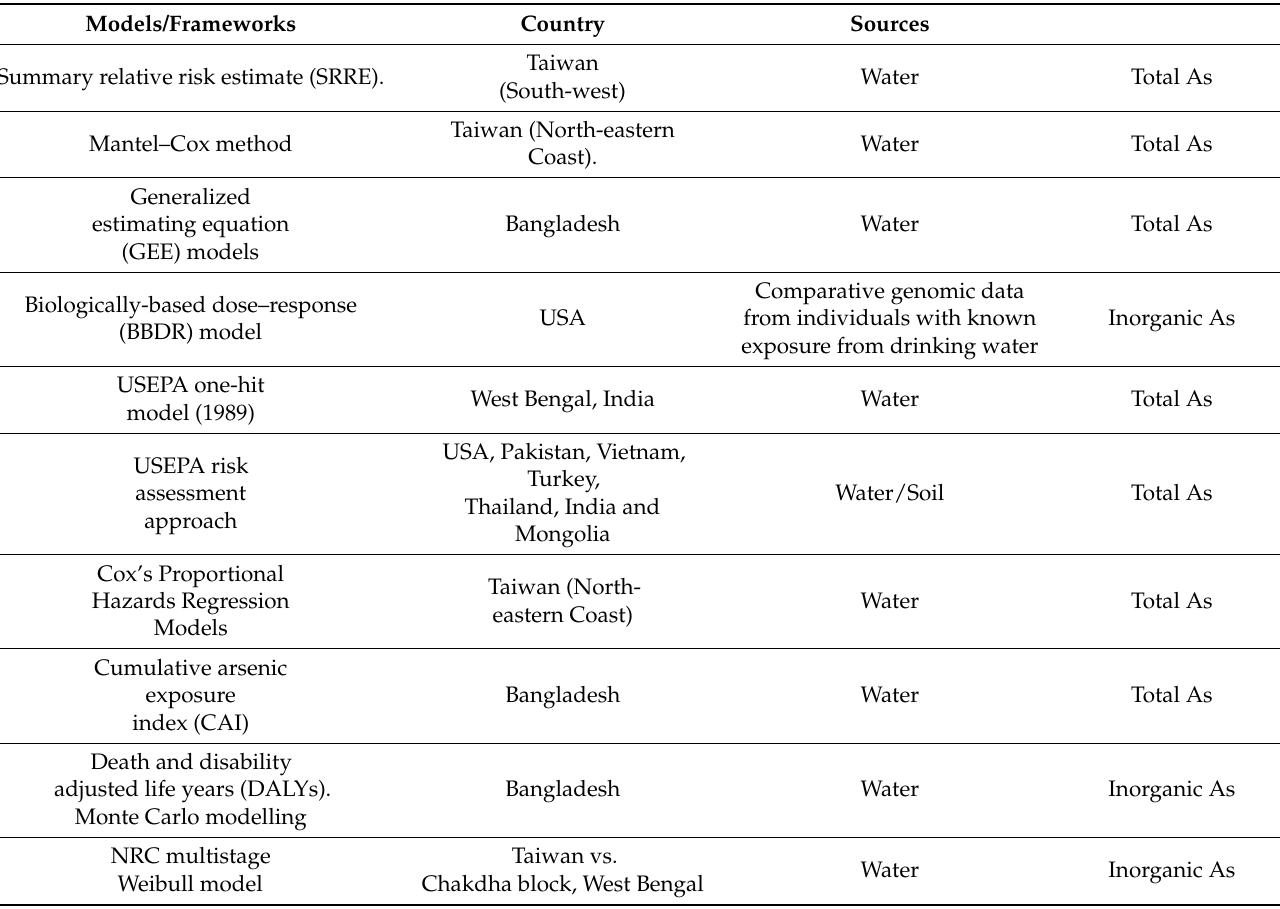
Table 16. Different models used for human health risk assessment